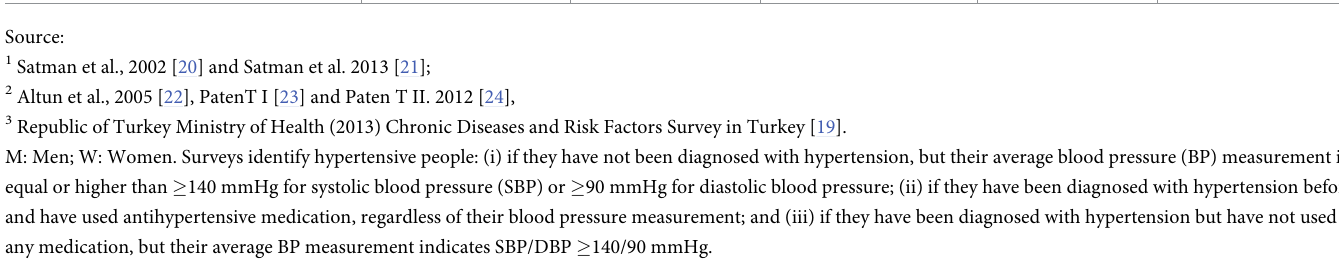
in women (48% and 70%) than in men (28% and 41%), respectively. Furthermore, nationwide surveys report increases in antihypertensive treatment among people with hypertension (Table 2) [22, 23, 24, 25]. For example, in 2012, 47.5% people with hypertension received anti- hypertensive treatment–up from 31% in 2003. Turkish MoH survey (CDRFS 2011) revealed higher awareness (63%) among people with hypertension and relatively higher percentage (57.5%) under the hypertension treatment. However, only 30% of the people who are under treatment maintains hypertension under con- trol. Furthermore, among those under treatment, 63% also have prescription medication for chronic diseases [19]. However, the improvements in awareness and the reduction in the num- ber and the rates of death associated with hypertension in Turkey are leveled off in recent